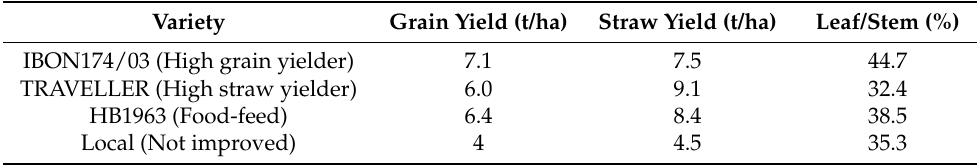
Table 1. Description of the barley varieties used in the study. Variety Grain Yield (t/ha) Straw Yield (t/ha) Leaf/Stem (%) IBON174/03 (High grain yielder) 7.1 7.5 44.7 TRAVELLER (High straw yielder) 6.0 9.1 32.4 HB1963 (Food-feed) 6.4 8.4 38.5 Local (Not improved) 4 4.5